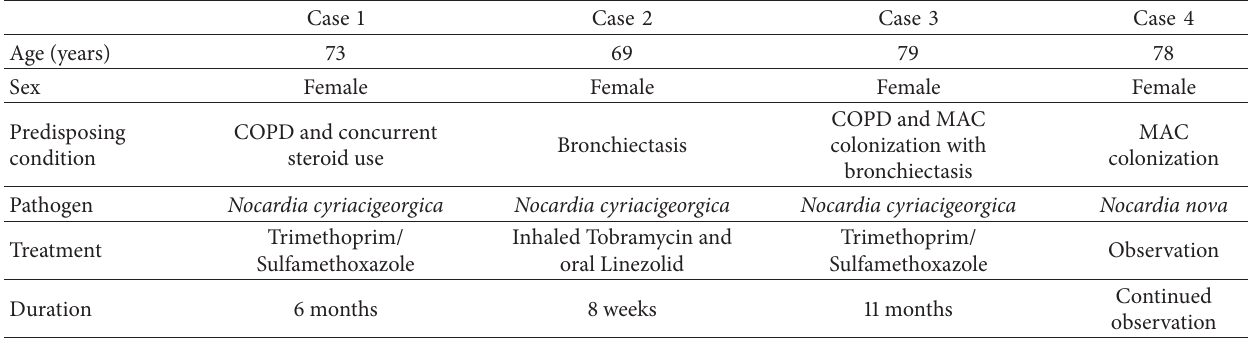
Table 2: Patient demographics, predisposing condition, and treatment